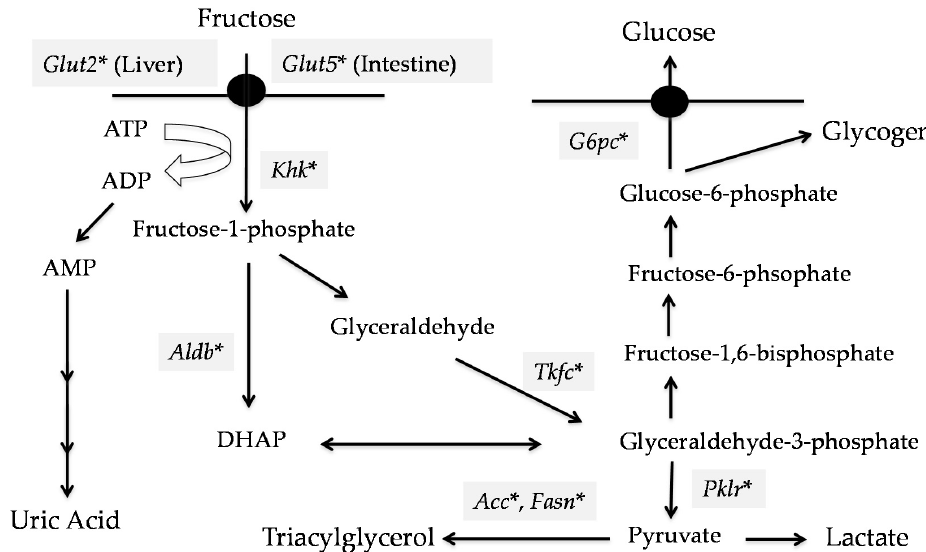
Figure 1. ChREBP regulates fructolytic gene expression. Fructose is transported by GLUT5 and metabolized by ketohexokinase, aldolase B, and triokinase. Dihydroxyacetone phosphate and glyceraldehyde-3-phosphate enter into the glycolytic or gluconeogenic pathway. * Genes are regulated by ChREBP [14,20,23–25]. Khk , ketohexokinase; G6pc , glucose-6-phosphatase catalytic subunit; Aldb , aldolase B; Pklr , pyruvate kinase, liver and reticulocyte type; Acc , acetyl coA carboxylase; Fasn , fatty acid synthase; Tkfc , triokinase; ChREBP, carbohydrate response element binding protein; GLUT2, glucose transporter 2; GLUT5, glucose transporter 5; DHAP, Dihydroxyacetone phosphate; ATP, adenosine triphosphate; ADP, adenosine diphosphate; AMP, adenosine monophosphate.